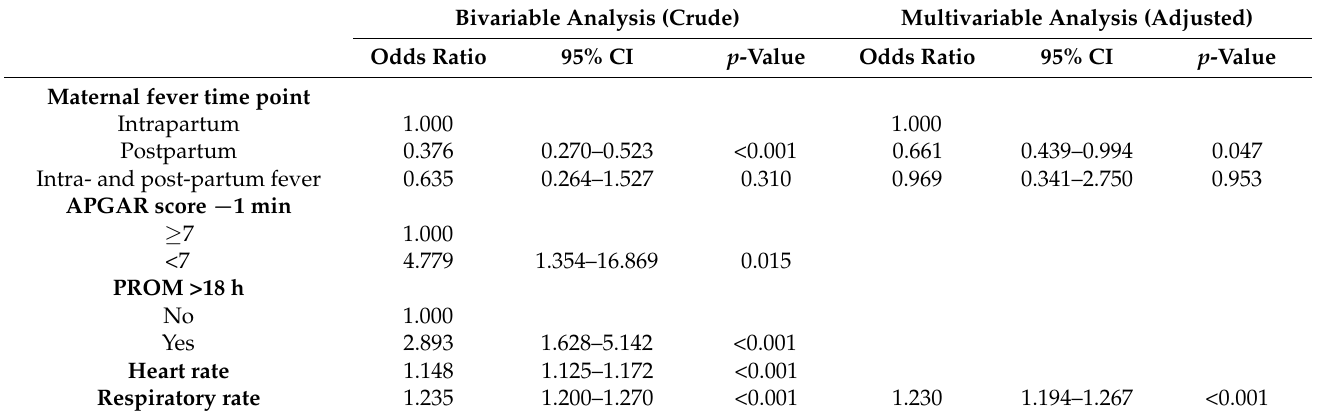
Figure 1. ROC curve to predict whether the baby has probable/proven sepsis based on the time point of the mother’s first fever (baby birth time as the origin) and infant’s respiratory rate. PPV, positive predictive value; NPV, negative predictive value; LR+, likelihood ratio for a positive test; LR − , likelihood ratio for a negative test; AUC, area under curve; SE, standard error; CI, confidence interval; hr, hour; min, minute. 4. Discussion Our results showed that newborns whose mothers developed postpartum fever were at a significantly lower risk of acquiring neonatal sepsis compared with those whose mothers developed intrapartum fever. It is clear that not all fevers of women in labor or postpartum are caused by microbial organisms. We also found that when the mother developed fever within 1.8 h postpartum and the baby exhibited rapid breathing after birth (>60 breaths/min), the positive predictive value for neonatal sepsis was 91.6%. By contrast, in the newborns in the unlikely sepsis group, 97.5% (specificity) of the mothers developed